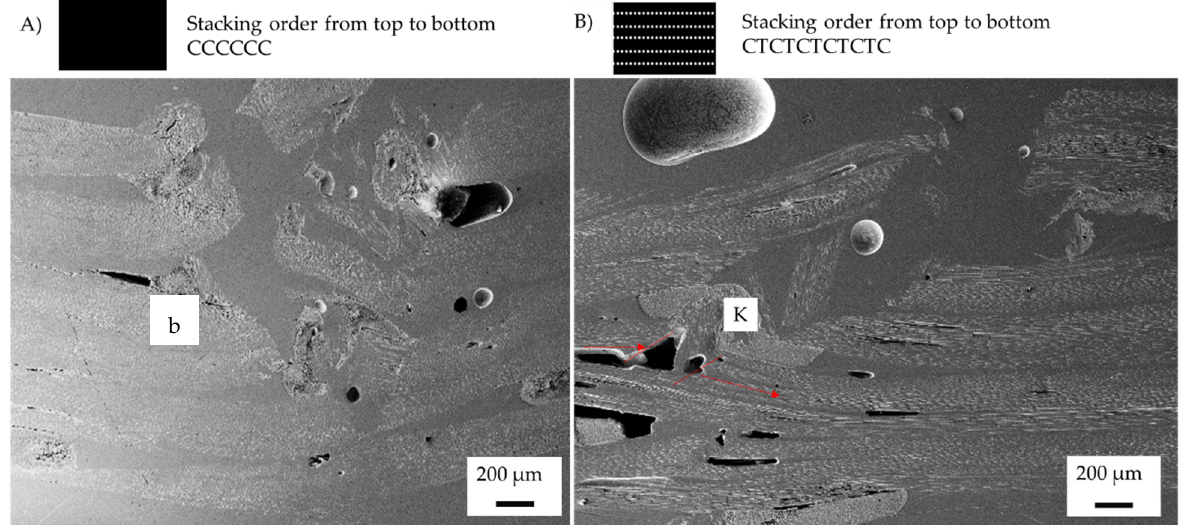
Figure 15. Post-failure micrographs of control samples after three-point bending and toughened samples with Xantu.Layr ® : ( A ) control carbon fibre (CF), ( B ) carbon fibre toughened (CFT)Annotation: K (fibre kinking) and b (fibre buckling). Red lines indicate fibre failure.